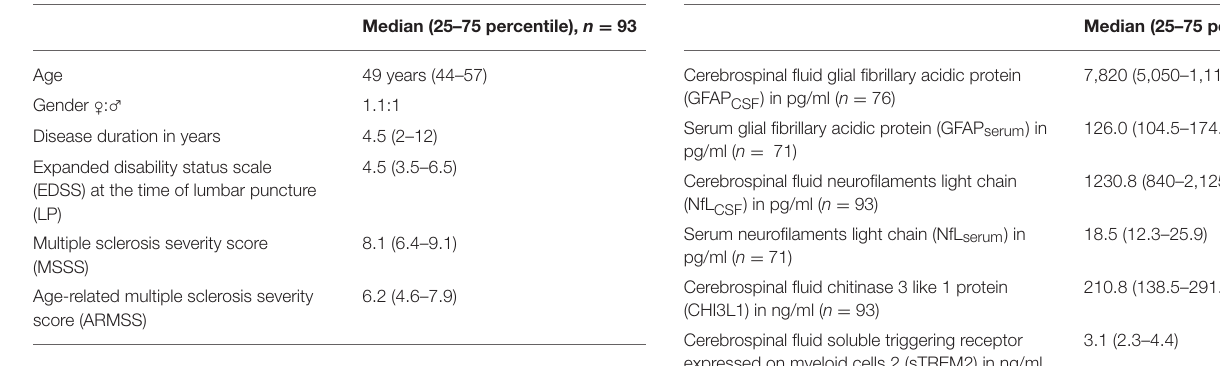
TABLE 1 | Clinical characteristics of the included subjects. TABLE 2 | Concentrations of the assessed biomarkers in CSF and